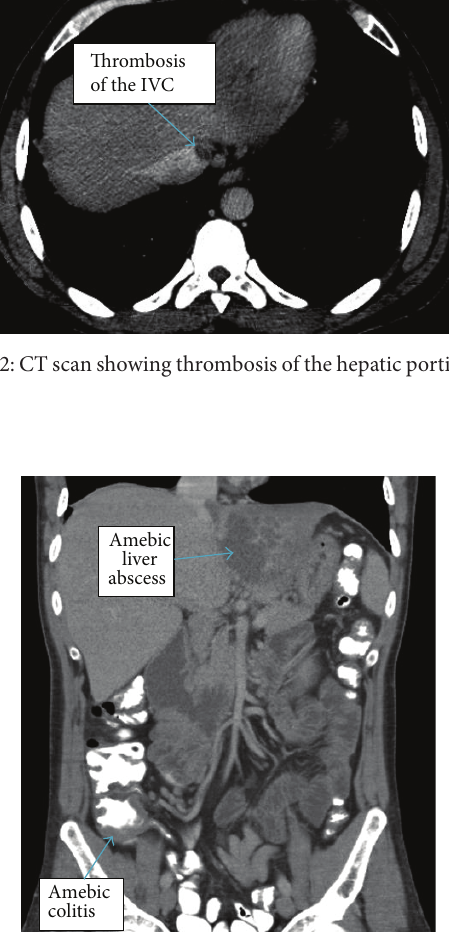
Figure 3: CT abdomen showing 8.5 × 9.6 × 6.8 cm liver mass and cecal wall thickening suggestive of